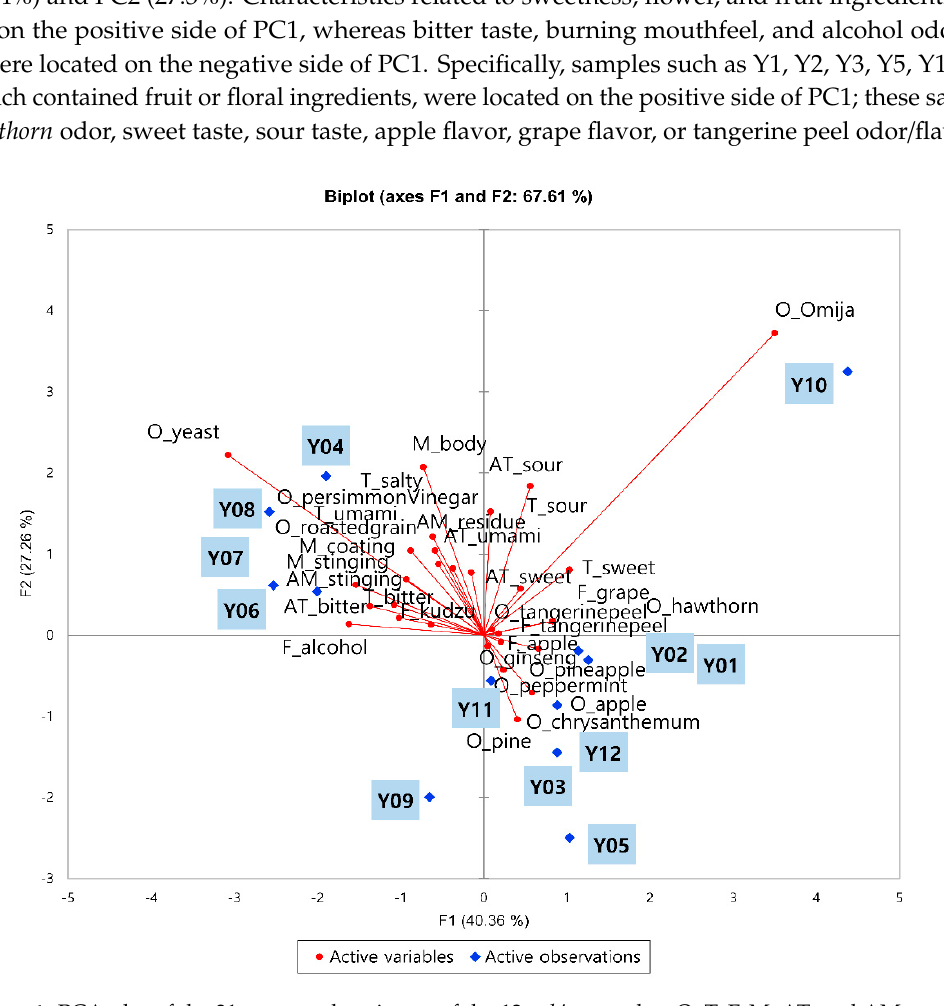
Figure 1. PCA plot of the 31 sensory descriptors of the 12 yakju samples. O, T, F, M, AT, and AM